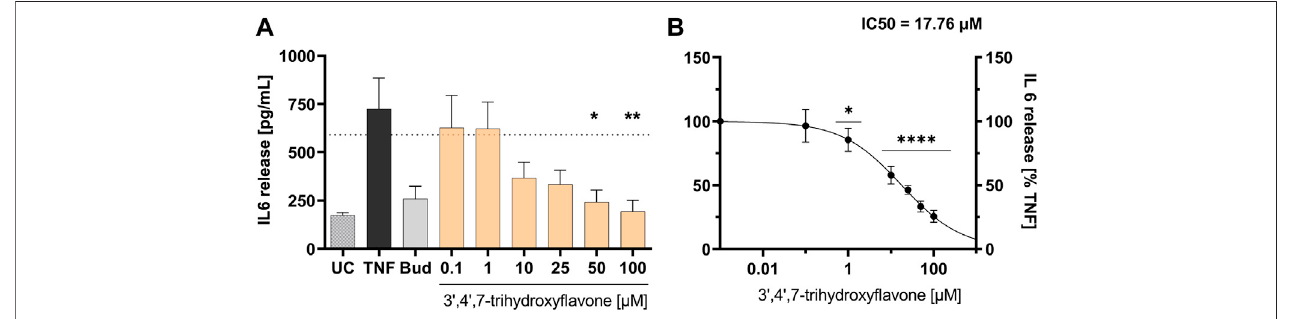
FIGURE3| In fl uenceof3 ′ ,4 ′ ,7-trihydroxy fl avone(1 – 100 µM)onTNF- α inducedin fl ammatorymediatorreleasefromHaCaTcells (A) .In fl uenceonIL-6release[pg/ mL]; (B) concentration response curve for theinhibition ofIL-6 release [% TNF- α control];UC =untreated control, TNF= TNF- α stimulation and untreated control, Bud= TNF- α stimulation and budesonide 10 mM. Mean ± standard error of the mean (SEM), n = 4 – 6, signi fi cant **** p ≤ 0.0001, ** p ≤ 0.01, and * p ≤ 0.05 compared to TNF- α treated cells ( = 100%) in ordinary 1-way ANOVA.